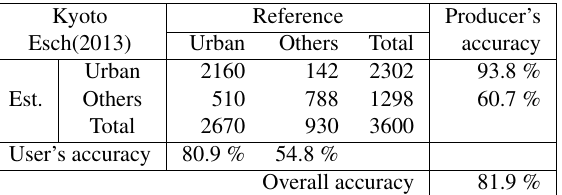
Table 4. Accuracy of extracted urban areas in study area 2 by using the method of Esch et al.(2013)